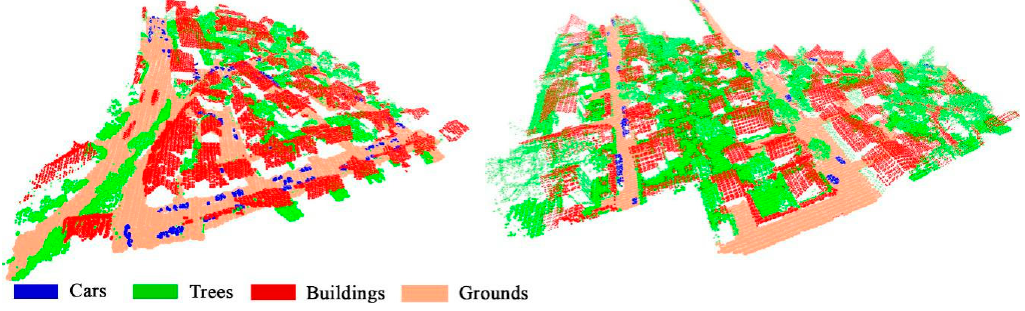
Figure 8. Classification results on ISPRS 3D Semantic Labeling Dataset. Table 10. Classification results of ISPRS 3D Semantic Labeling Dataset (%). Precision/Recall/IoU/F1-score, OA, mIoU, Kappa and mF1 (%).